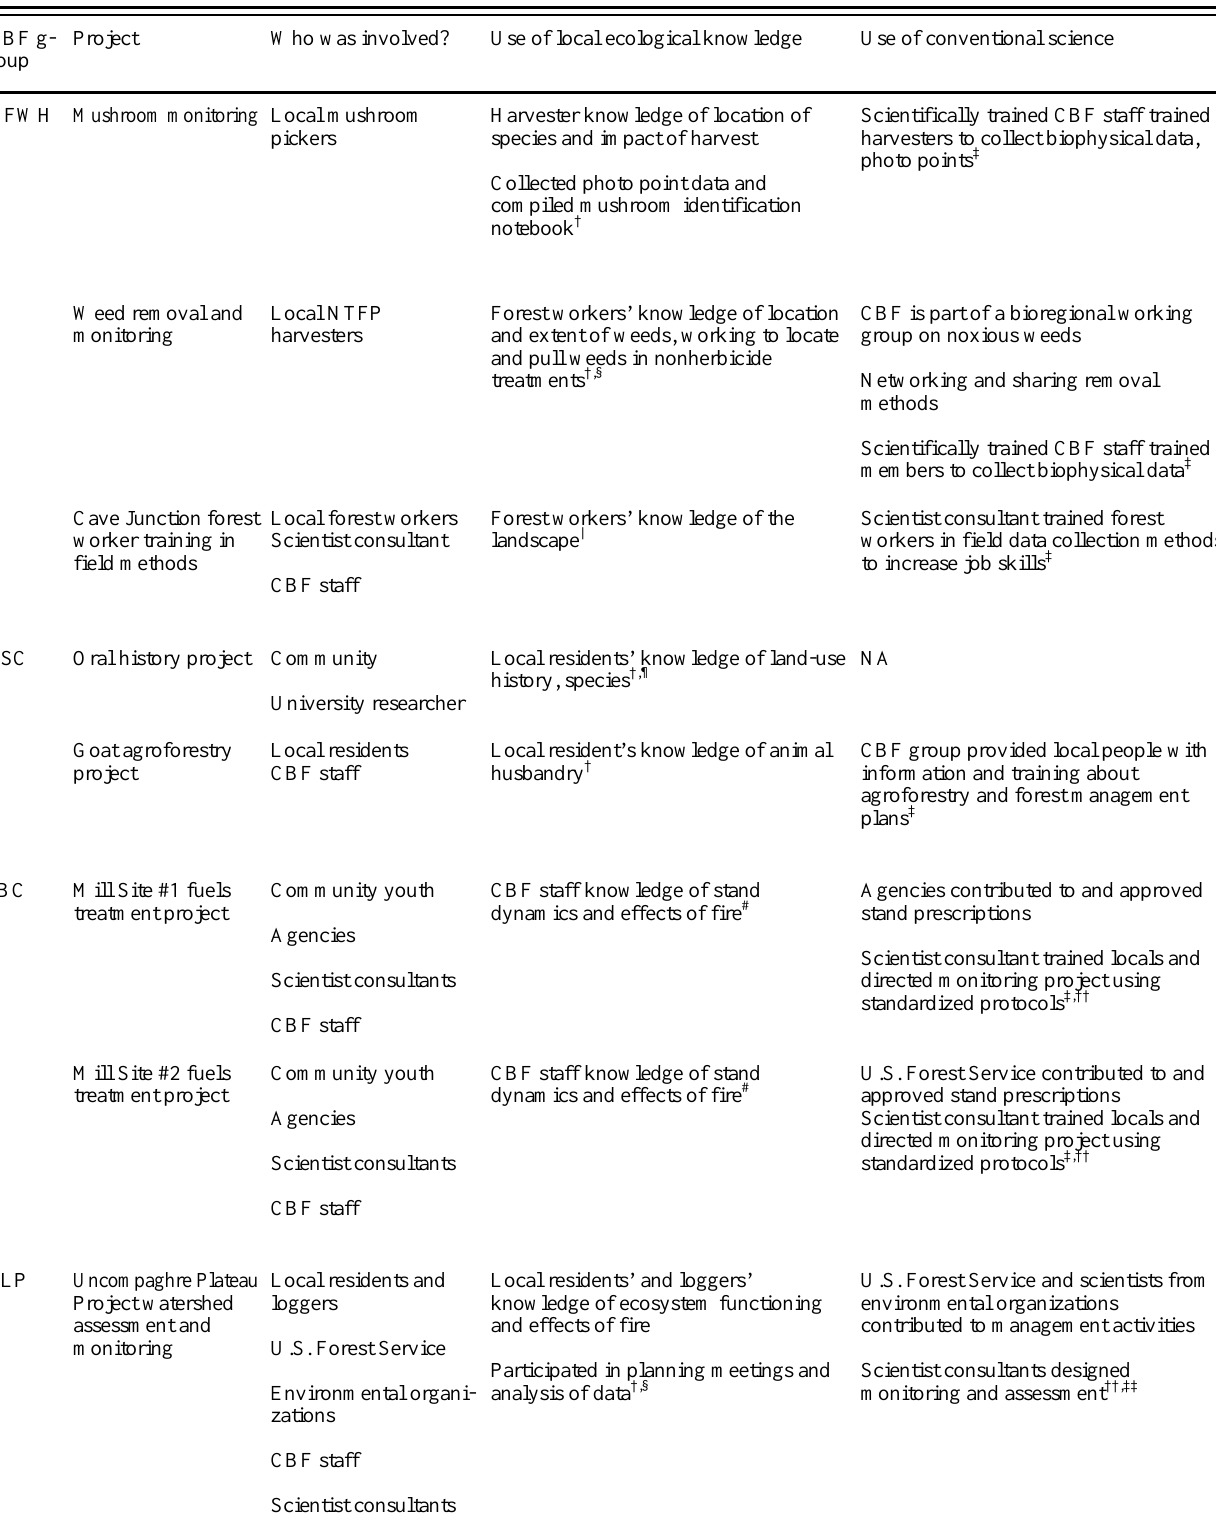
Table 2. Overview of projects, participants, and use of local ecological knowledge and conventional science in 24 projects of the seven community-based forestry (CBF) groups